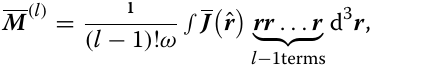
MS, metasurface; CP, circular